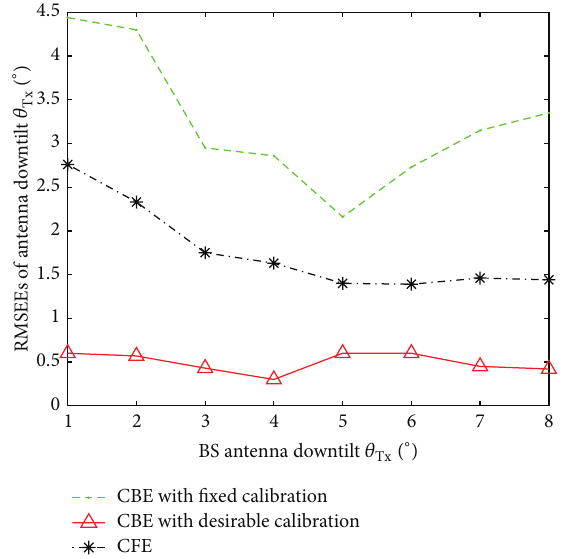
) versus 𝜃 Figure 11: RMSEE (𝜃 obtained by using the CFE Tx Tx method and two CBE methods which make use of, respectively, “desirable” or “fixed” calibration